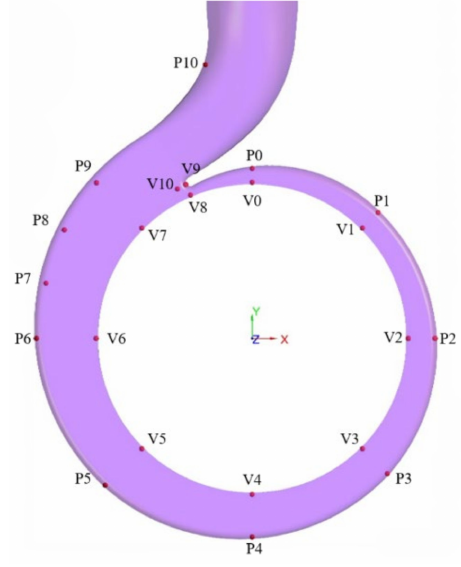
Figure 2. Monitoring points in the